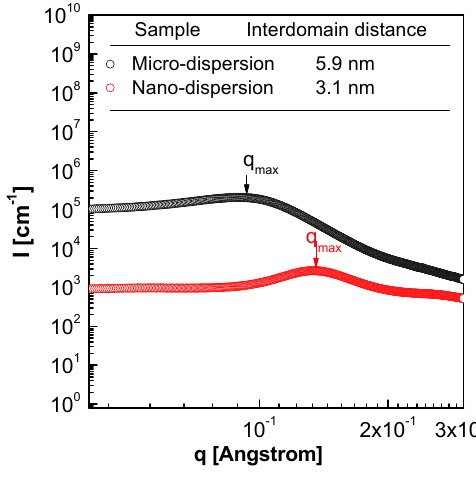
Figure 7. SAXS spectra of solidified-state Nafion